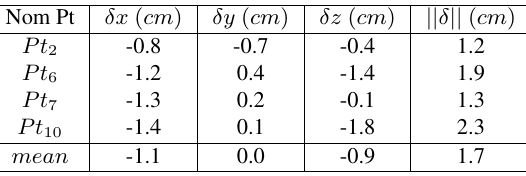
Table 2: Residuals on check points for auto-calibration